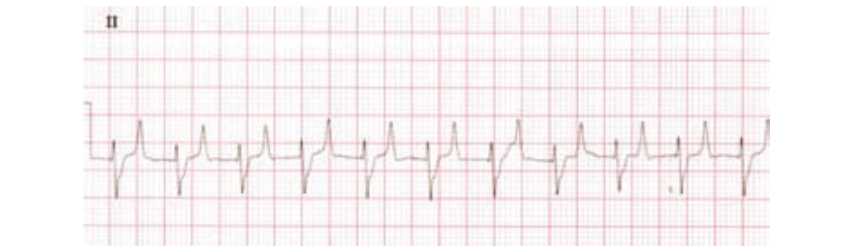
Fig. 5 . ECG of animal number S2, showing atrial standstill and sino-ventricular rhythm, rS pattern of QRS complex with deep S waves, peaked T waves, wide QRS complexes and prolonged QT interval (Paper speed – 25 mm/sec)